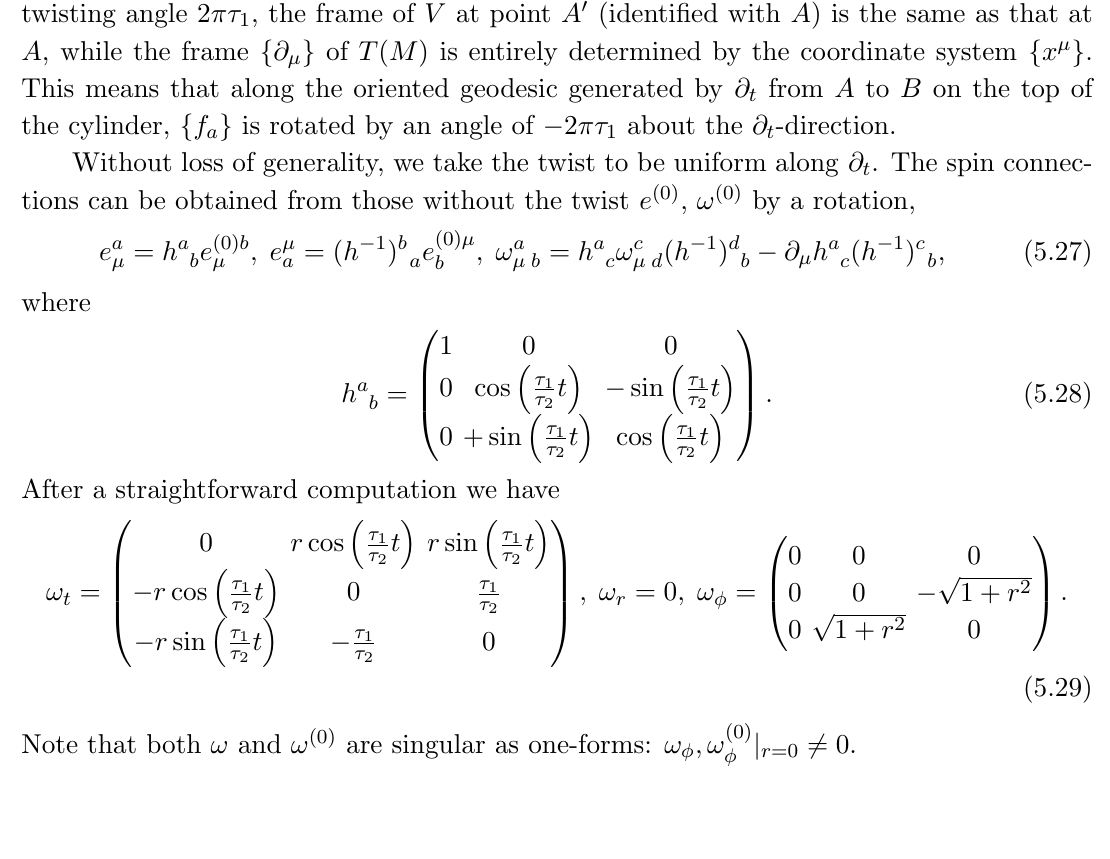
3 . Blue arrows denote coordinate frames f @ (cid:22) g of T ( M ) and red f a of V . The Dreibein is an isomorphism between f g